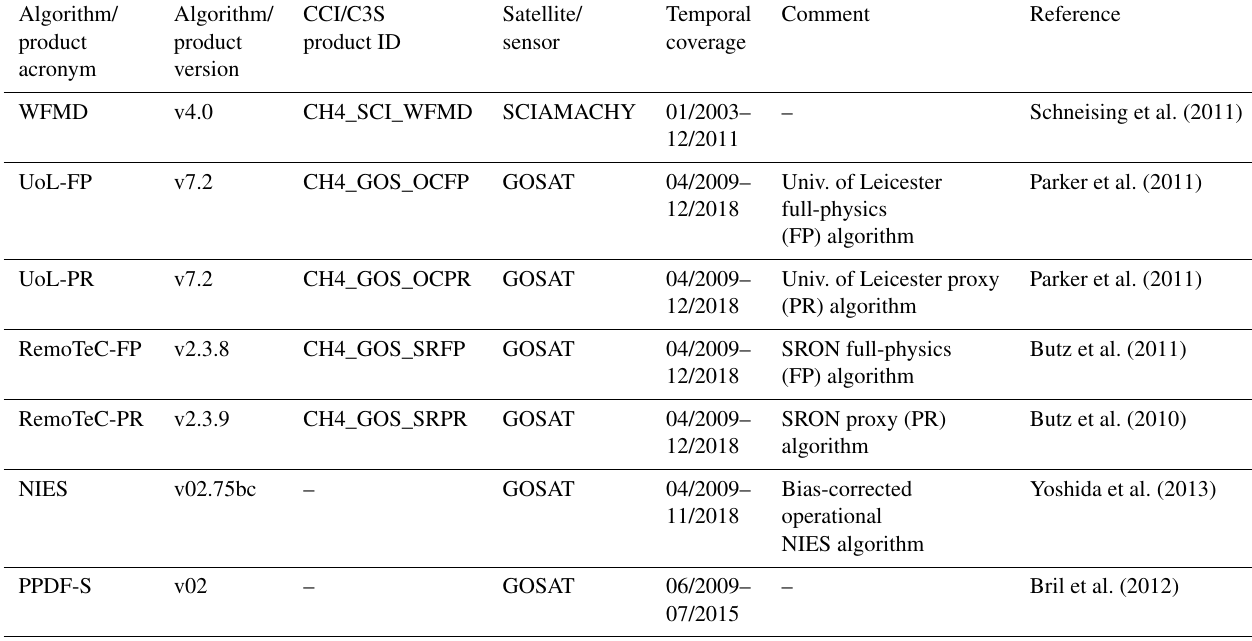
Table 2. As Table 1 but for XCH 4 .